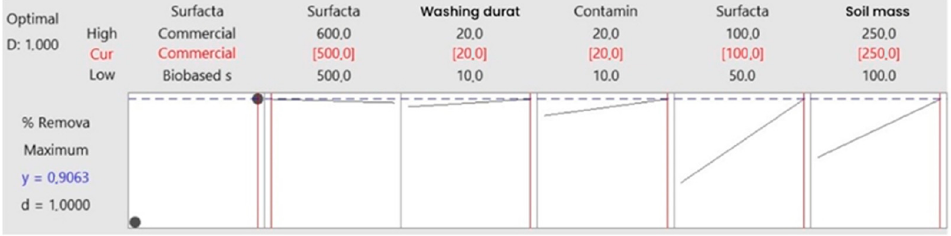
Figure 7. Pareto Chart of the standardized e ff ects of Soil mass and Washing duration on the oil removal (%). The e ff ect of curvature was also signi fi cant ( p -value = 0.001), which points to the pos- sibility of adding quadratic terms to the regression model, indicating proximity to an op- timization region, with permissiveness for the application of the response surface experi- ment model (CCRD). The value of coe ffi cient of determination (R 2 ), which indicates the goodness-of- fi t for the model, was 0.9890, that is, more than 98% of the variability of the mathematical regression model can be explained by the studied factors. Since the adjusted